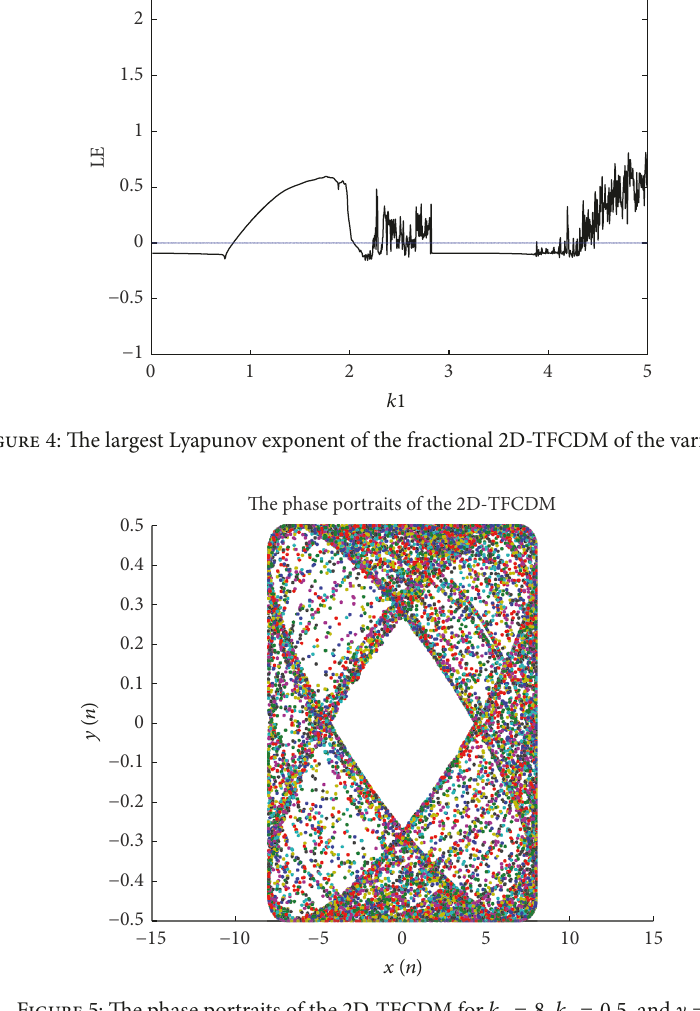
Figure 5: The phase portraits of the 2D-TFCDM for 𝑘 1 = 8 , 𝑘 2 = 0.5 , and ] = 1